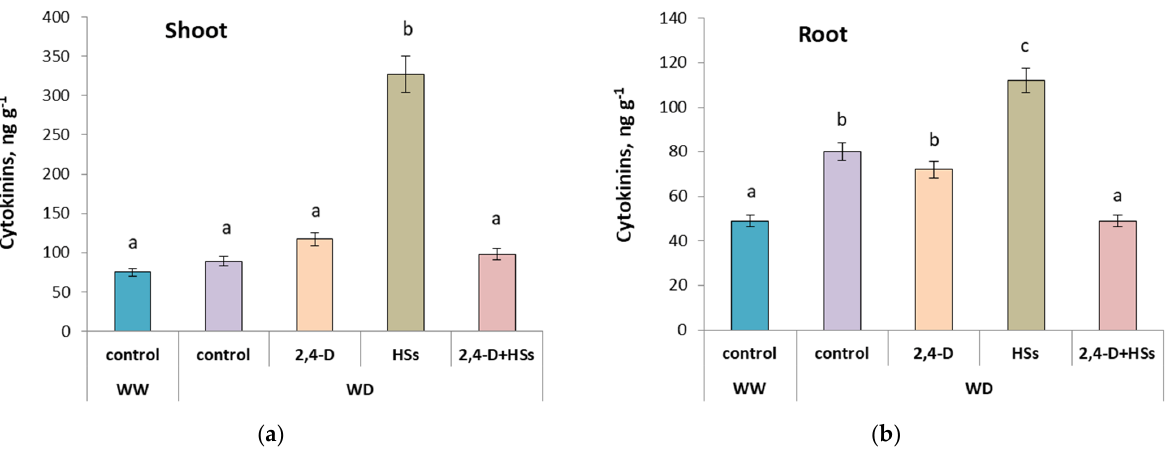
Figure 7. Cytokinins concentration in shoots ( a ) and roots ( b ) of wheat plants 3 day after treatment with Pseudomonas plecoglossicida 2,4 ‐ D (2,4 ‐ D), humic substances (HSs) and their combinations (2,4 ‐ D + HSs) under well ‐ watering (WW) and in water deficit (WD) conditions. Statistically different means are marked with different letters, p ≤ 0.05, n = 9 (ANOVA followed by Duncan’s test). Table 10. ANOVA test for shoot cytokinins content followed by Duncan test. Values in the cells correspond to p for the difference between the mean values; p ≤ 0.05 is marked with *; p ≤ 0.01— with ** for control plants untreated with either bacteria or HSs and plants grown under water deficit (WD): control, plants treated with Pseudomonas plecoglossicida 2,4 ‐ D (2,4 ‐ D), humic substances (HSs) and their combinations (2,4 ‐ D + HSs).